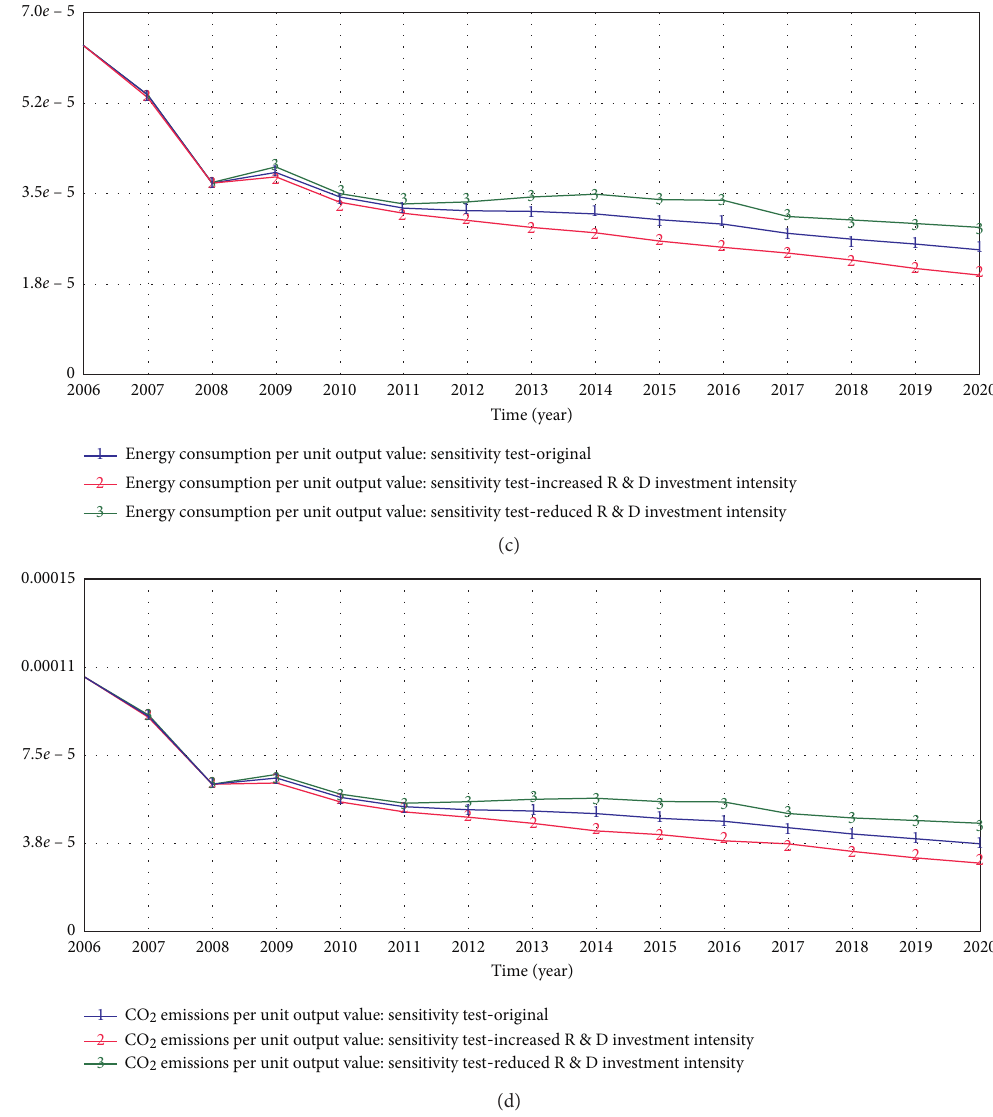
Figure 4: Parameter sensitivity test results. (a) CO unit output value. (d) CO 2 emission per unit output value.